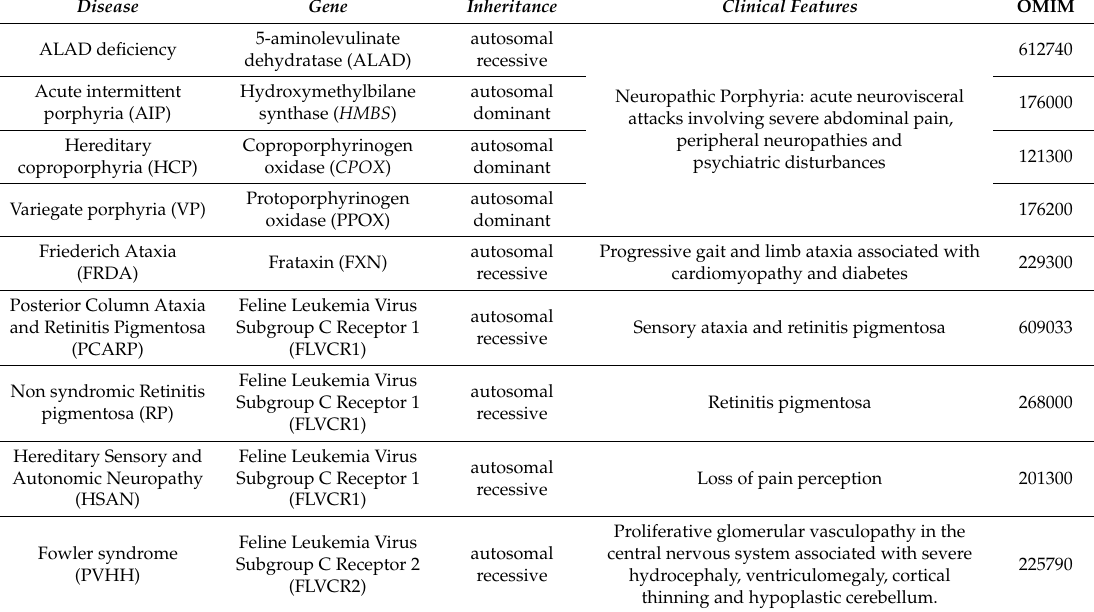
Table 1. Rare neurodegenerative disorders linked to defective heme